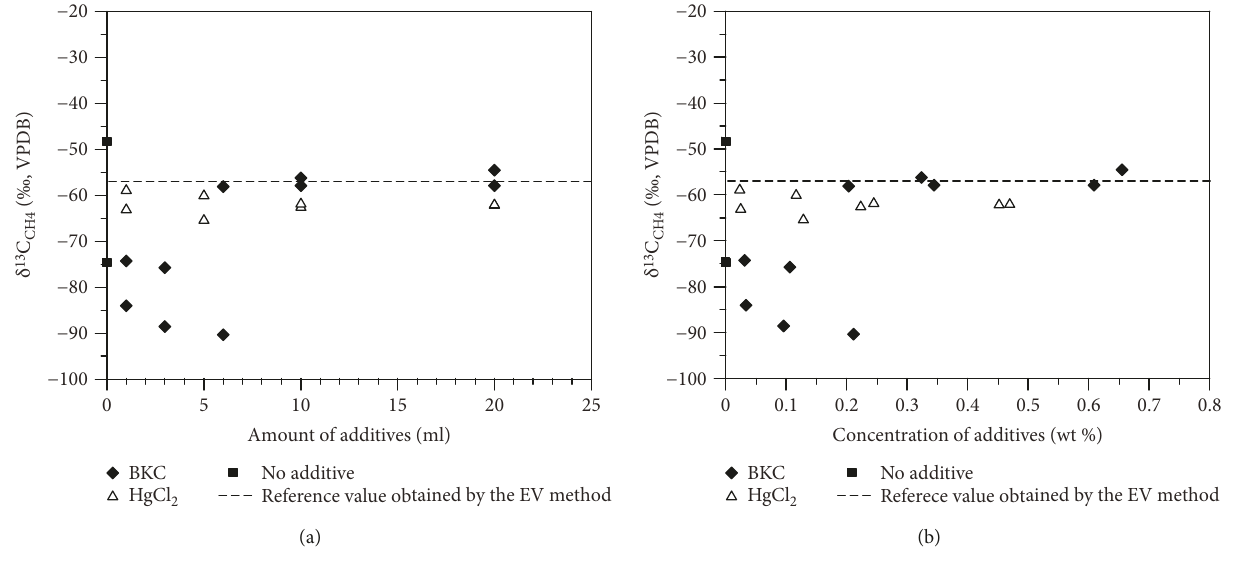
Figure 7: Plot of δ 13 C values vs. (a) amount of microbial suppressant used and (b) concentration of CH4